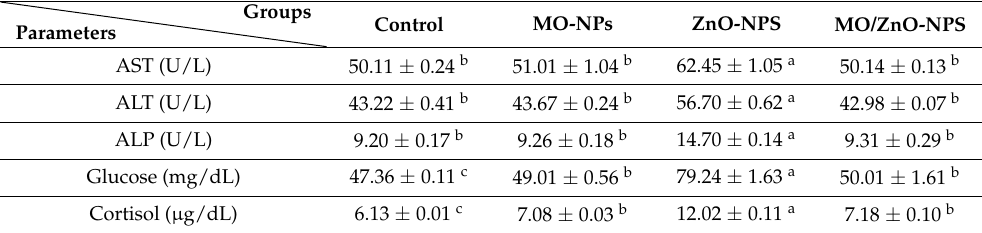
Where: Means with different superscript letter in the same row for each parameter are significantly different ( p < 0.05). MO-NPs group: fish fed diet supplemented with (2.5 g/kg diet) moringa nanoparticles (Mo-NPs),